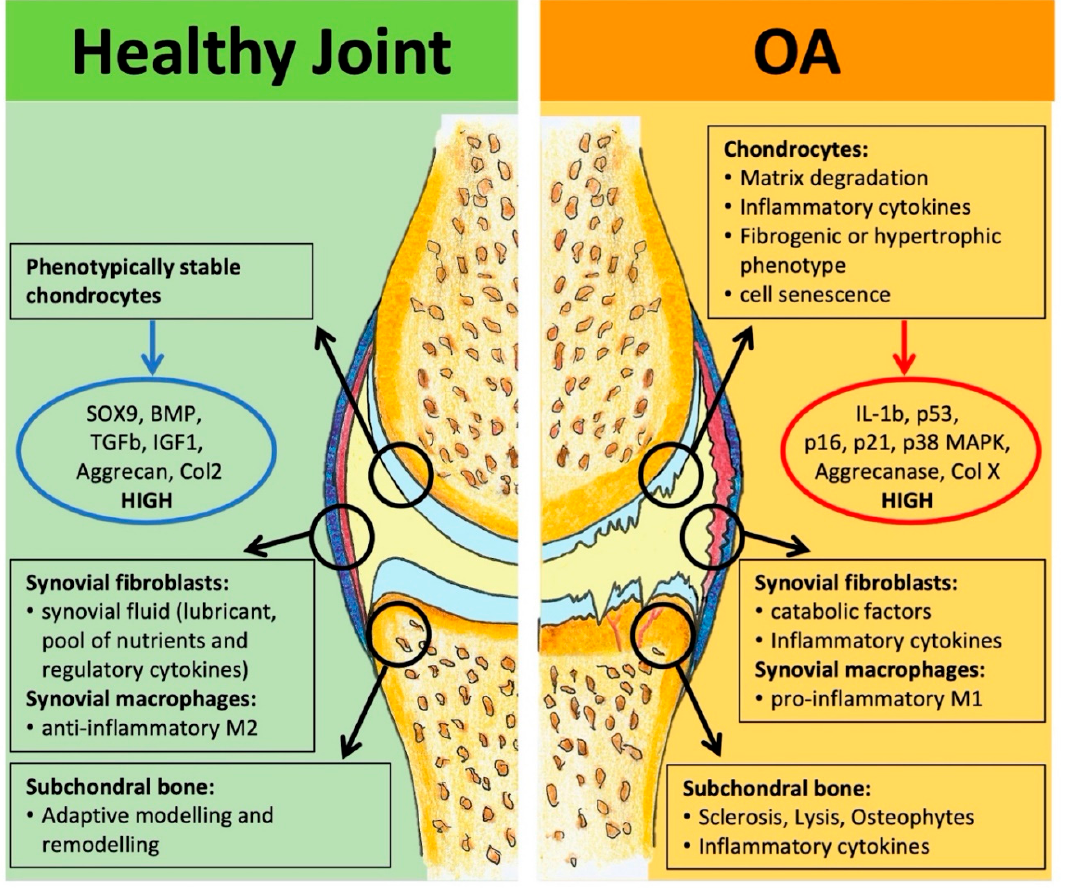
Figure 2. Characteristics of the different articular cells and tissues in healthy joints and in osteoarthritis (OA).